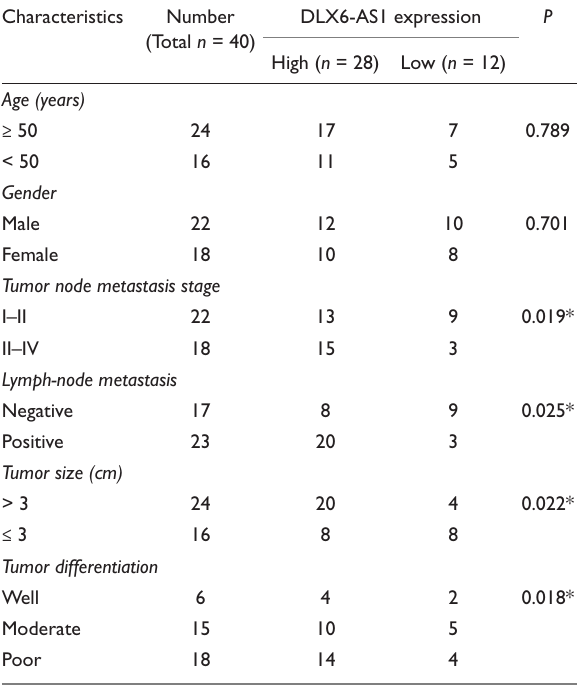
Table 1. Relationship of lncRNA DLX6-AS1 expression and clini- cal variables among 40 OS patients Characteristics